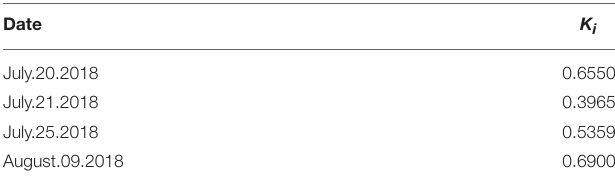
TABLE 1 | Daily attenuation coefficient K i